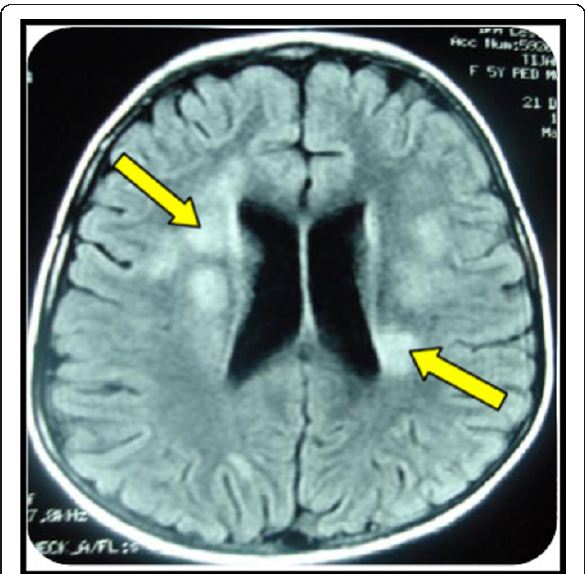
Figure 3 Brain MRI of the patient with juvenile form of MLD .